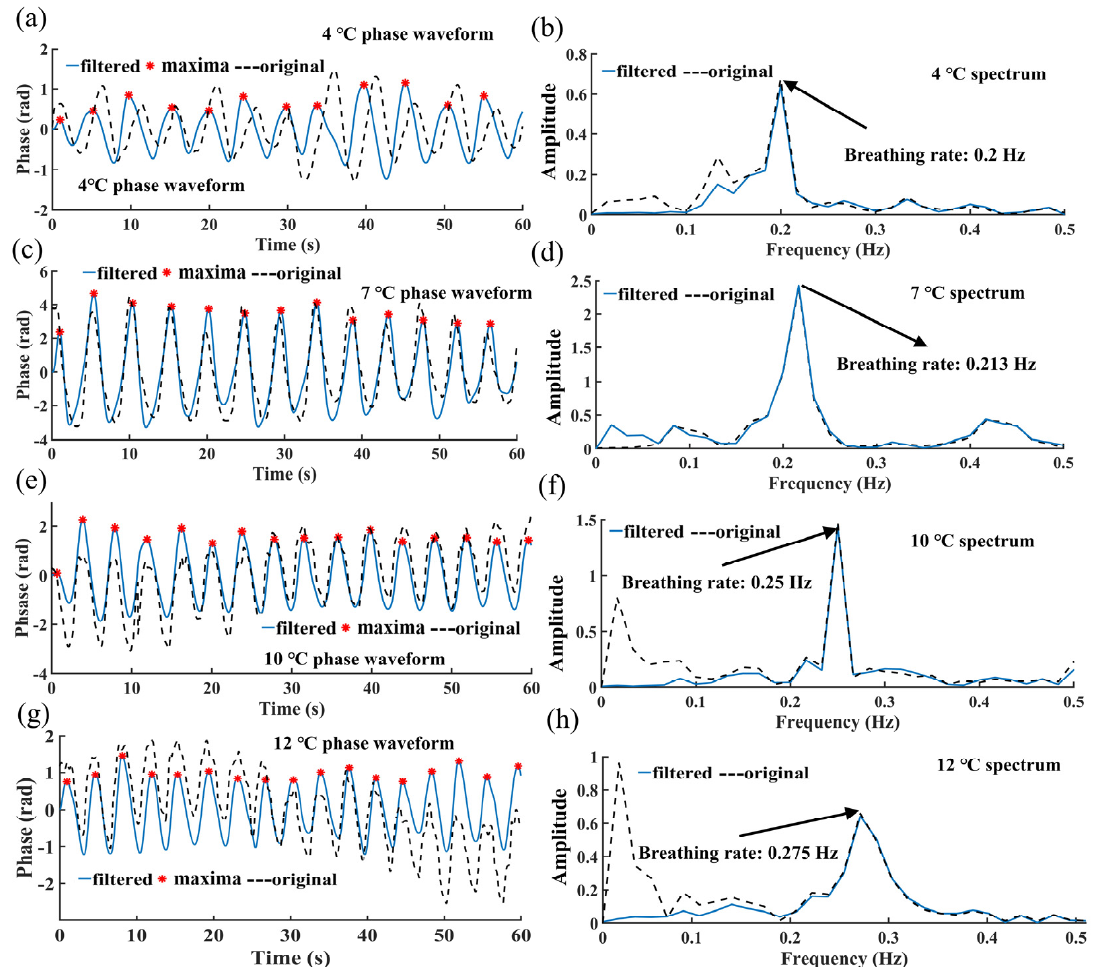
Figure 6. Breathing signal filtering and PI in preliminary experiments. ( a ) Breathing signal phase waveform at 4 ◦ C; ( b ) Breathing signal spectrum at 4 ◦ C; ( c ) Breathing signal phase waveform at 7 ◦ C; ( d ) Breathing signal spectrum at 7 ◦ C; ( e ) Breathing signal phase waveform at 10 ◦ C; ( f ) Breathing signal spectrum at 10 ◦ C; ( g ) Breathing signal phase waveform at 12 ◦ C; ( h ) Breathing signal spectrum at 12 ◦ C. The blue solid line represents the filtered, the black dashed line represents the measured original and the red stars represent the local maximum used to calculate the respiration rate.